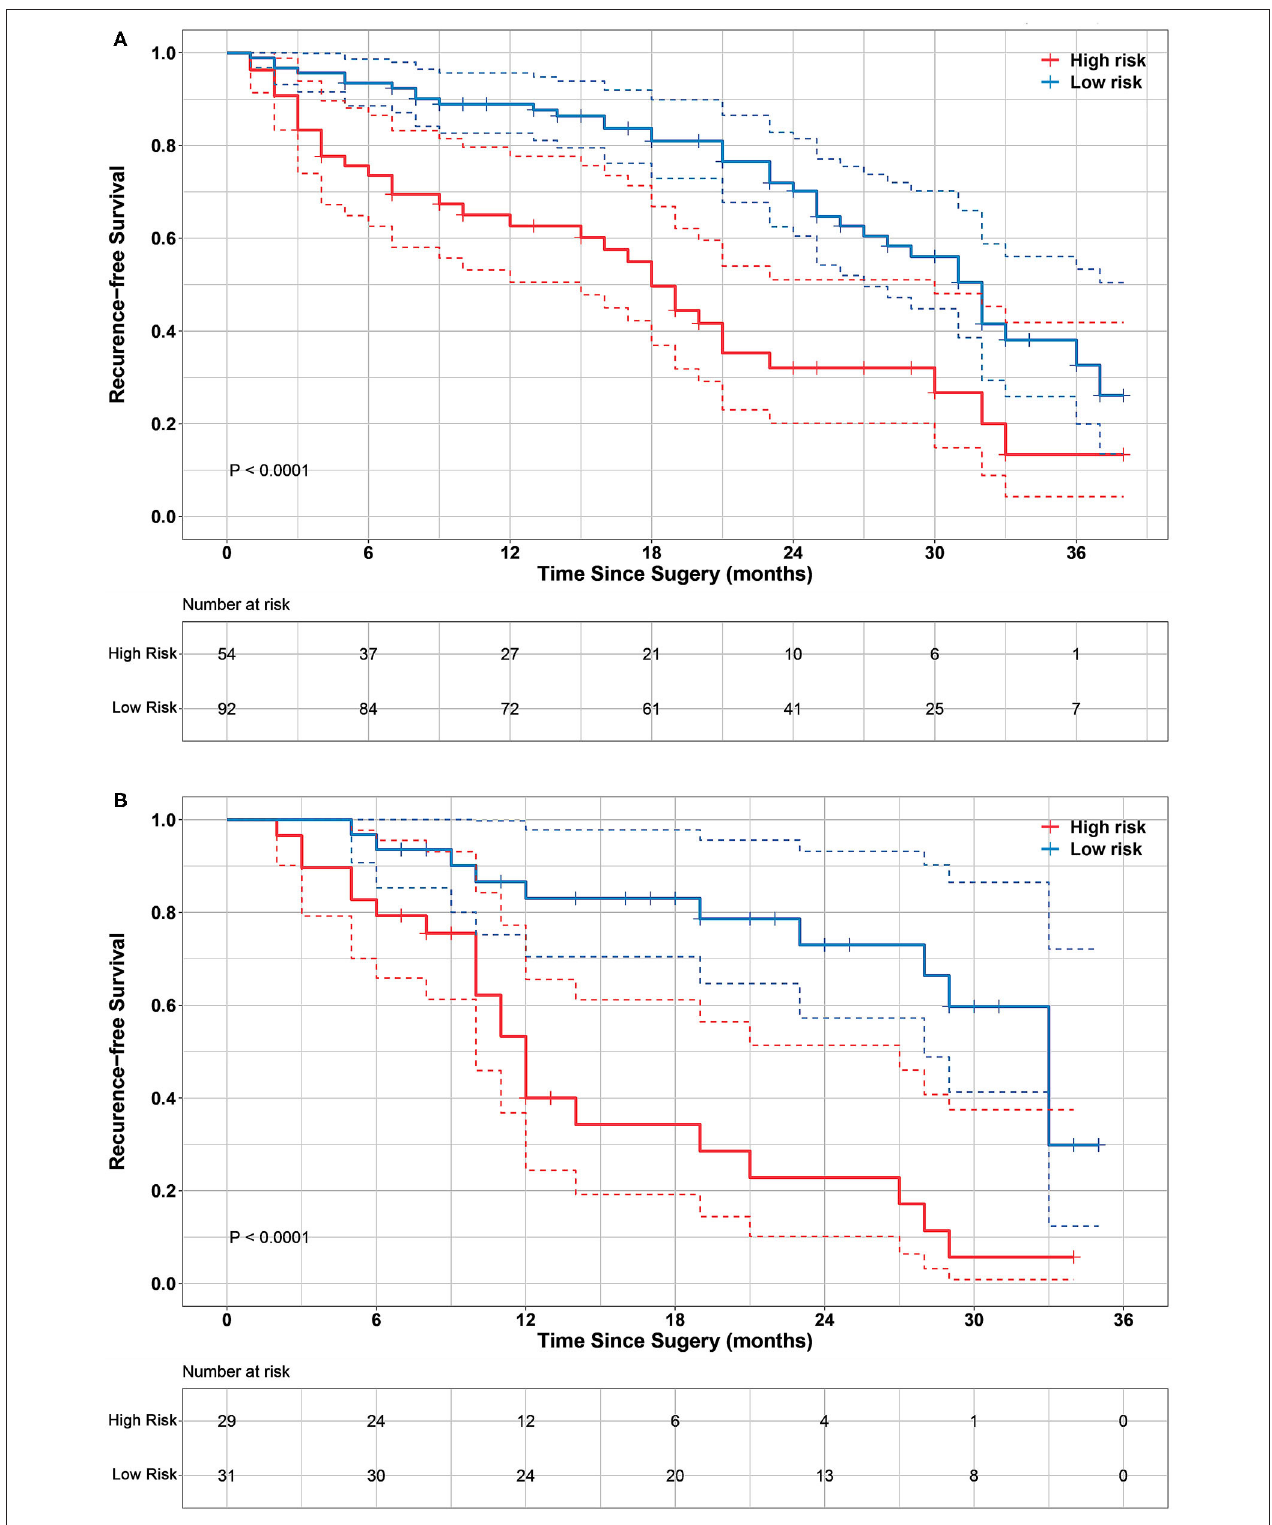
FIGURE 3 | Kaplan-Meier survival analyses of high-risk and low-risk groups divided by radiomics signature in training cohort (A) and validation cohort (B) . Significant differences were observed in both training cohort (log-rank test P < 0.0001) and validation cohort (log-rank test P < 0.0001). It indicates that radiomics signature significantly associated with RFS. Dashed line in the two-sided CI of survival curves.